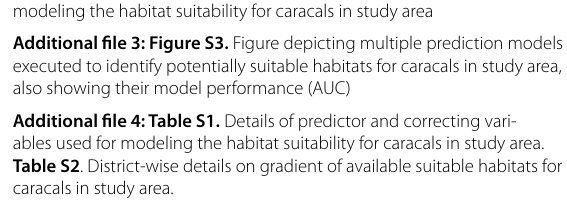
Table S2 . District-wise details on gradient of available suitable habitats for caracals in study